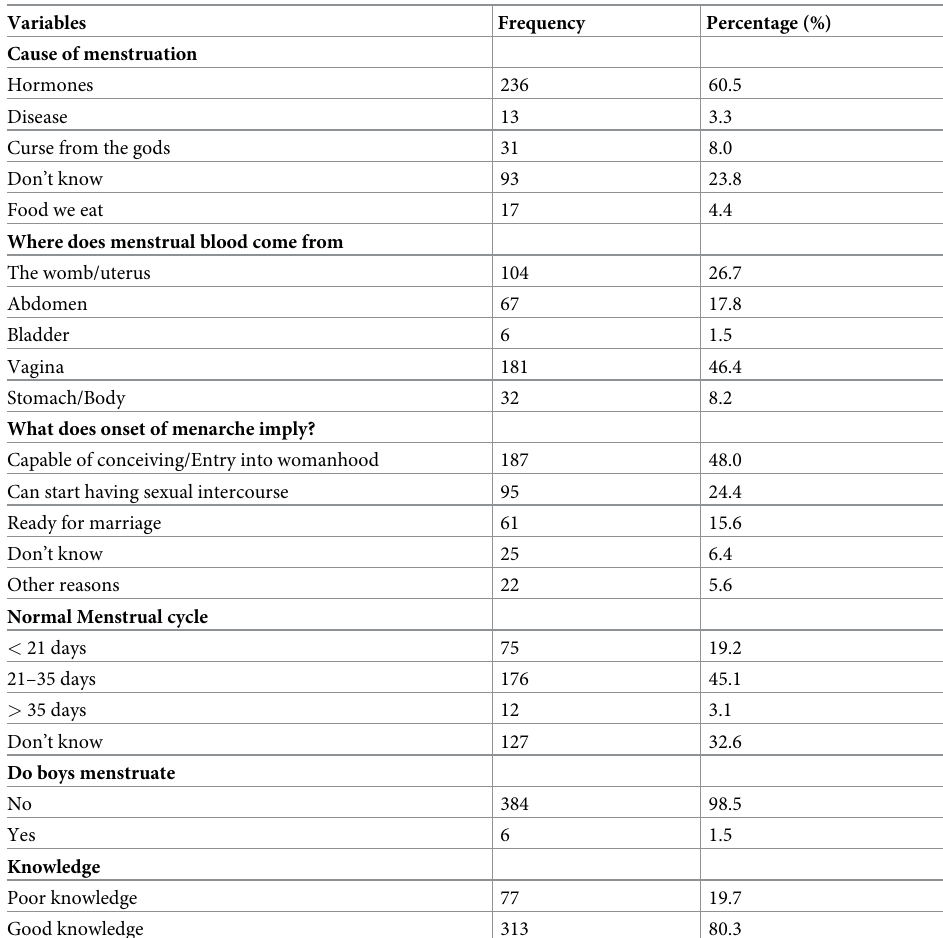
Table 2. Knowledge of